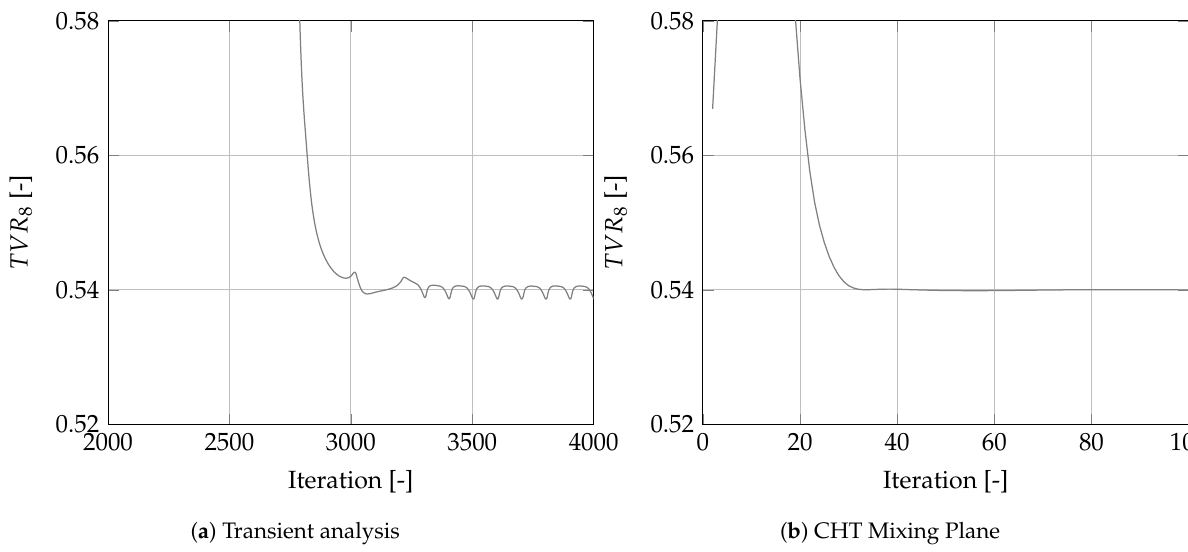
Figure 10. Convergence behavior of